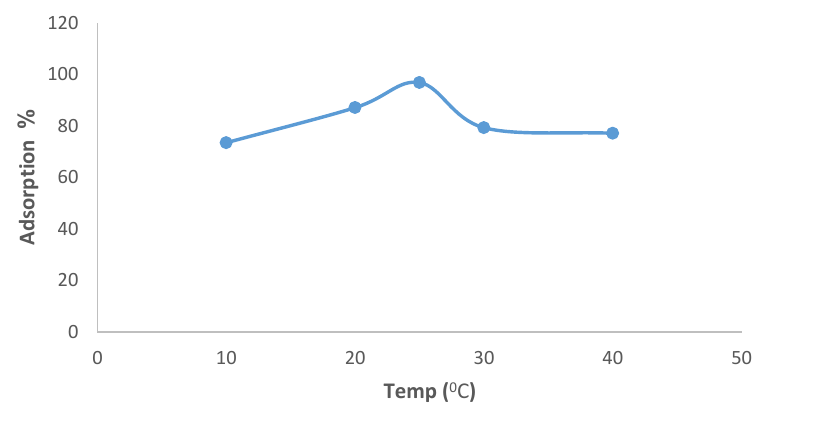
Table 1. Percentage of methyl orange dye output based on initial concentration changes